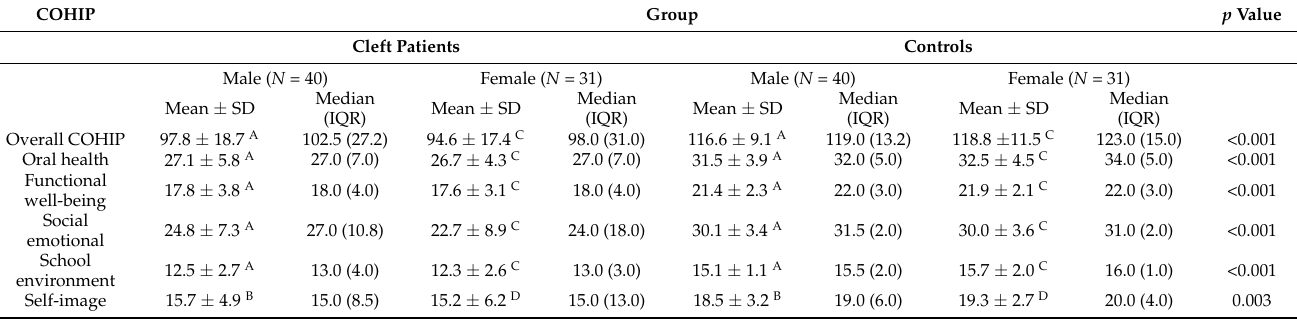
Table 4. Overall and subscale COHIP scores by gender and group.